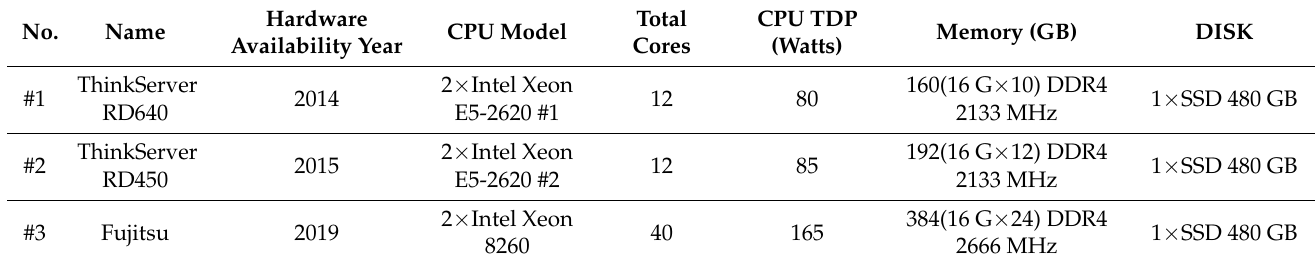
Table 3. Base configuration of tested 2U servers.